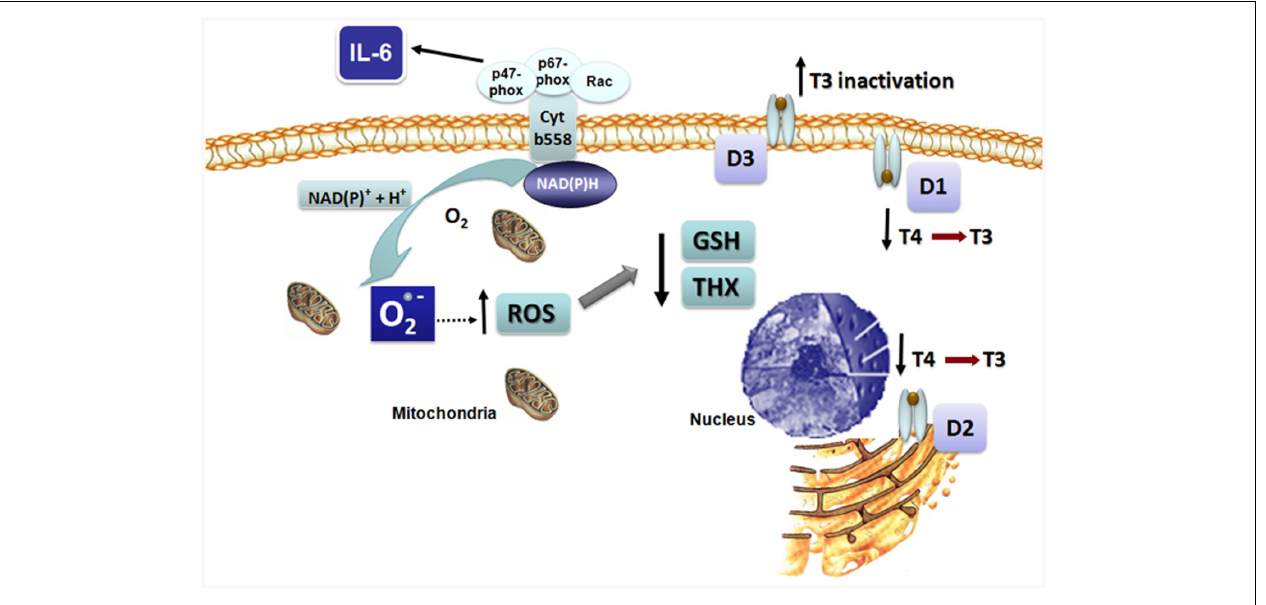
formation and oxidative stress. Impaired function of D1 and D2 secondary to diminished intracellular thiol concentrations results in decreasedT4 toT3 conversion, while increase D3 activity augmentsT3